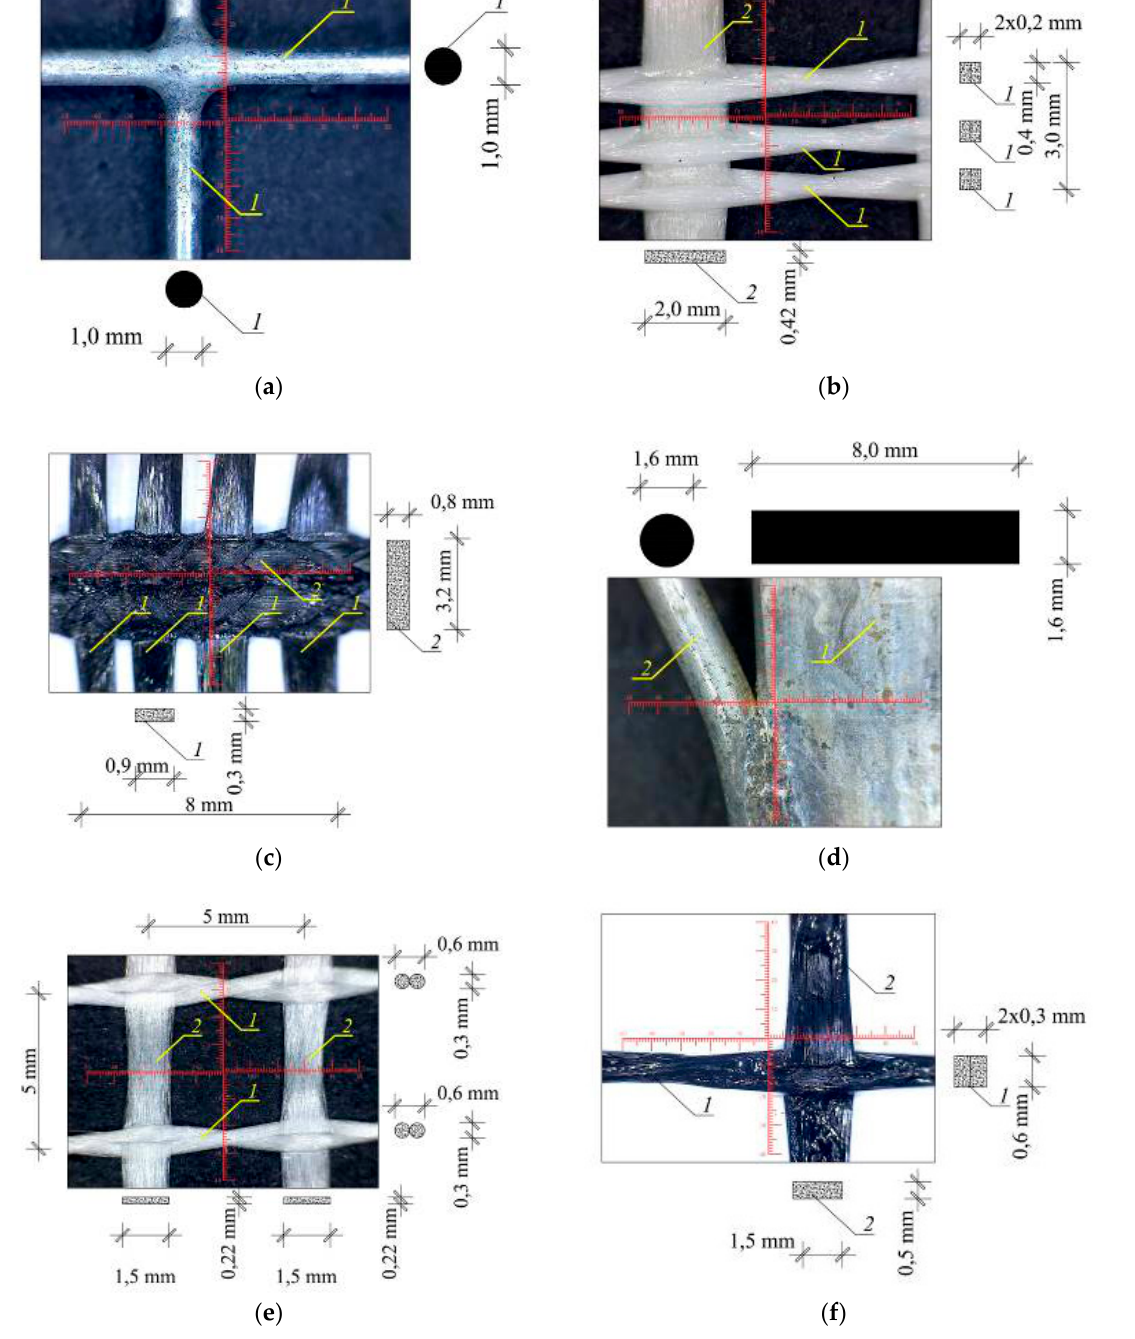
Figure 2. Microscopic view of reinforcement used in tests: ( a ) steel mesh reinforcement with a diameter of 1.2 mm, ( b ) fibreglass mesh (size 10 × 12 mm), ( c ) basalt fibre mesh (size 30 × 30 mm), ( d ) truss-type reinforcement, ( e ) fibreglass mesh (size 5 × 5 mm), ( f ) basalt fibre mesh (size 10 × 10 mm).